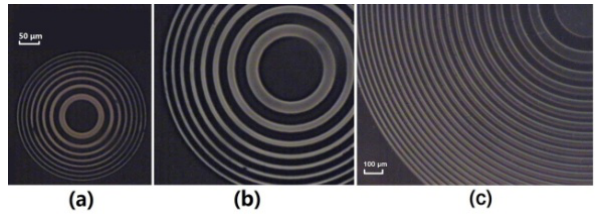
Figure 11. Optical microphotograph of the designed Fresnel zone lens under crossed polarizers [35]. ( a ) LC Fresnel zone lens (lens I) with the focal length of 3.2 mm; ( b ) the zoomed-in version of ( a ); ( c ) LC Fresnel zone lens (lens II) with the focal length of 50